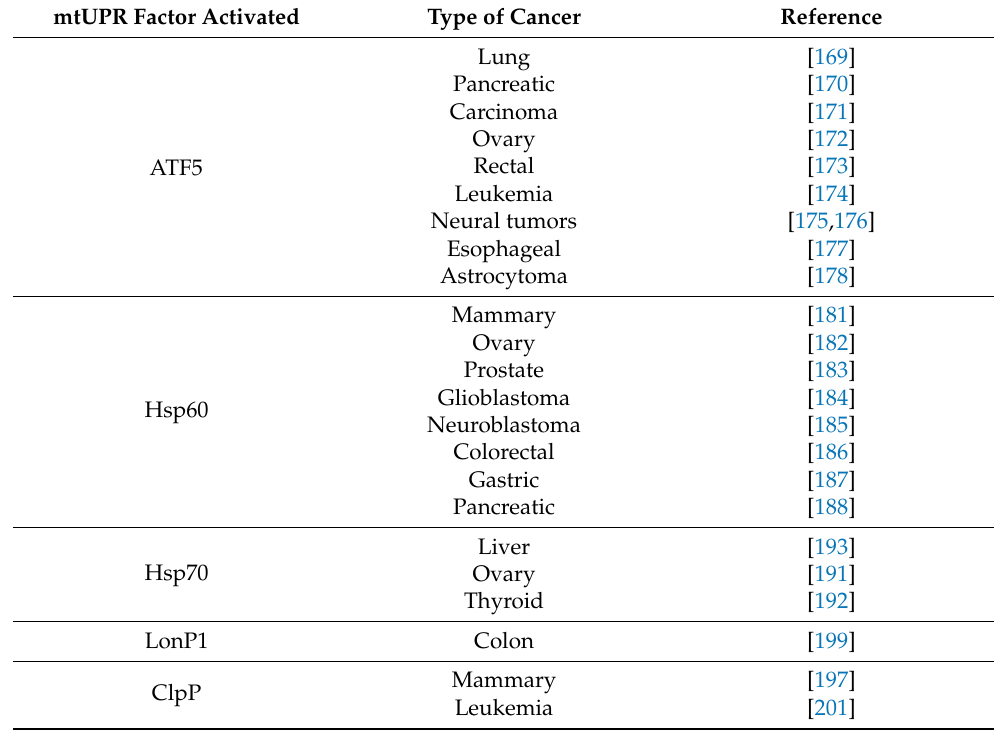
Table 2. Summary of mtUPR factor activation in different types of